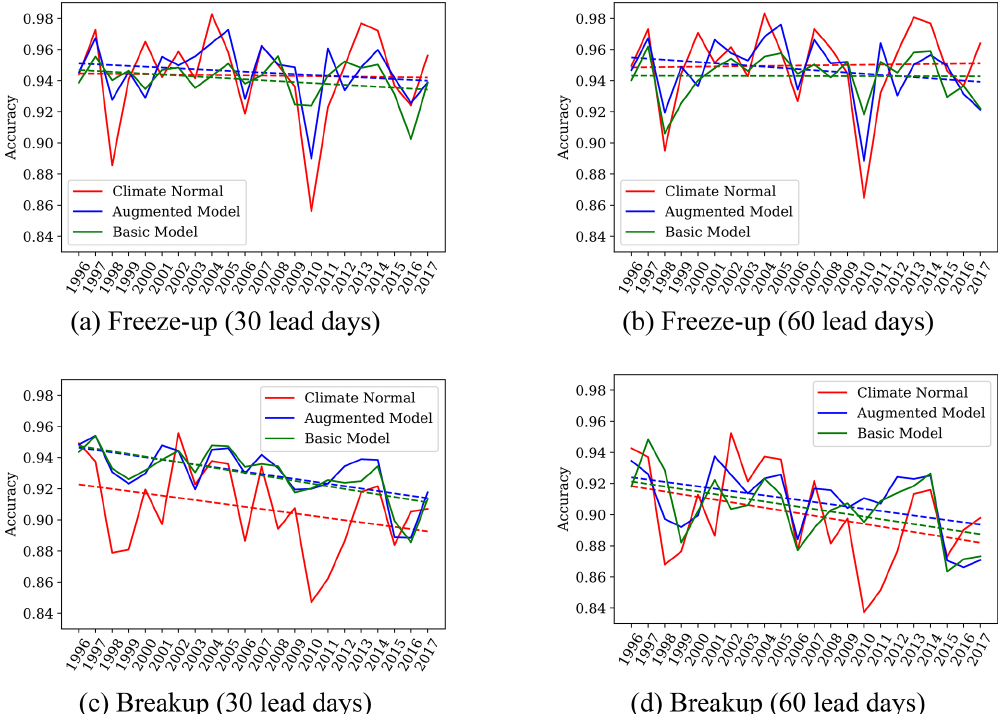
Figure 10. Accuracy of the Climate Normal, Basic model, and Augmented model freeze-up and breakup predictions over the years at 30 and 60 lead days. Dashed lines show the